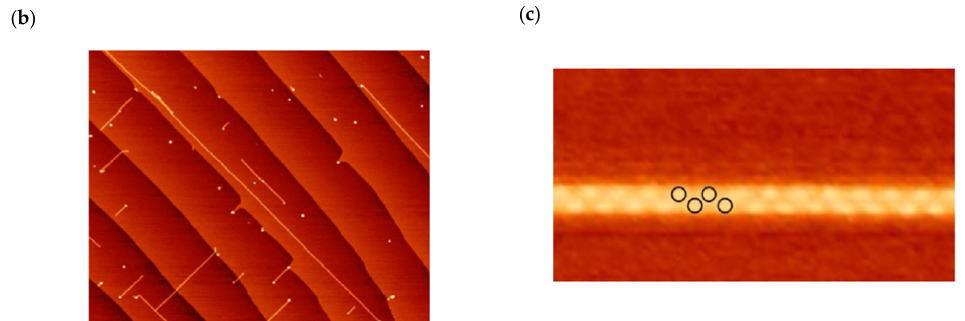
Figure 9. ( a ) Chemical pathway for the light-induced polymerization of N,N ′ -(1,4-phenylene)dimaleimide into a poly(N-substituted)dimaleimide chains. ( b ) AFM image (1000 × 1000 nm 2 ) of a long fibres of poly(N-substituted)dimaleimide on a KCl(001) surface. ( c ) Zoom of ( b ) (20 × 10 nm 2 ) showing a zig-zag structure. This reflects a topological rumpling of the fiber due to a coincidence of every fifth molecule with the fourth cation along the KCl(001) crystal axis.